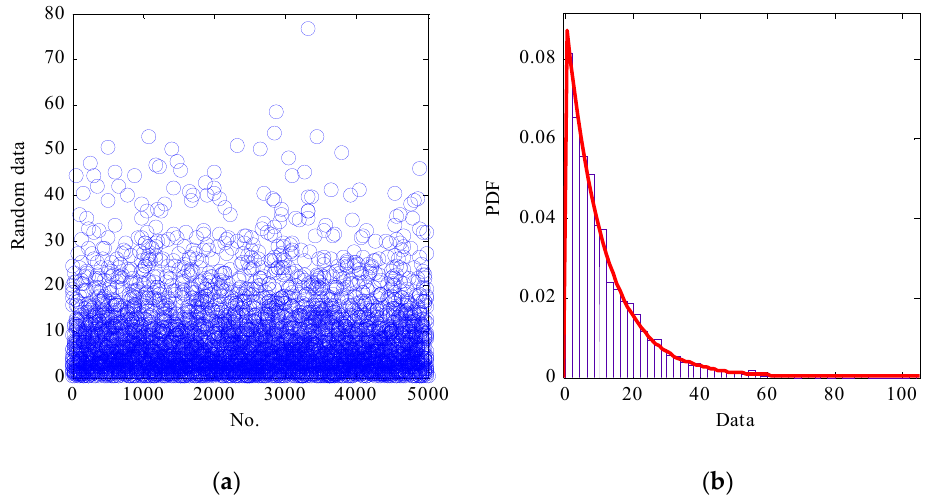
Figure 21. ( a ) Sample points and ( b ) probability density distribution of the points for parameter p 1.